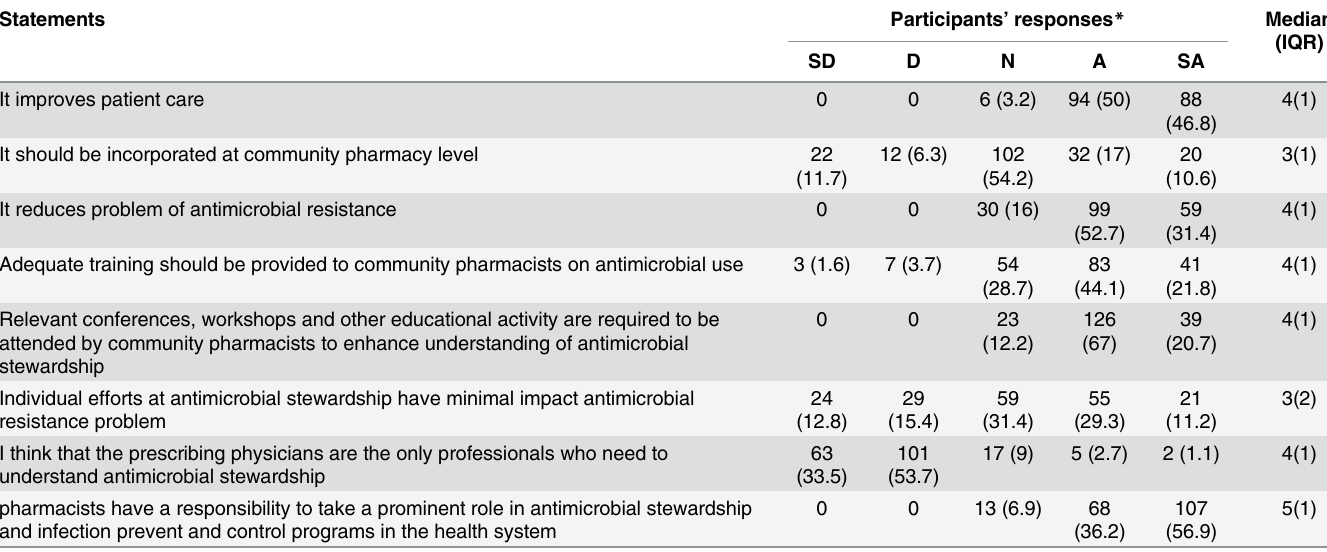
Table 2. Perception of participants towards antimicrobial stewardship.